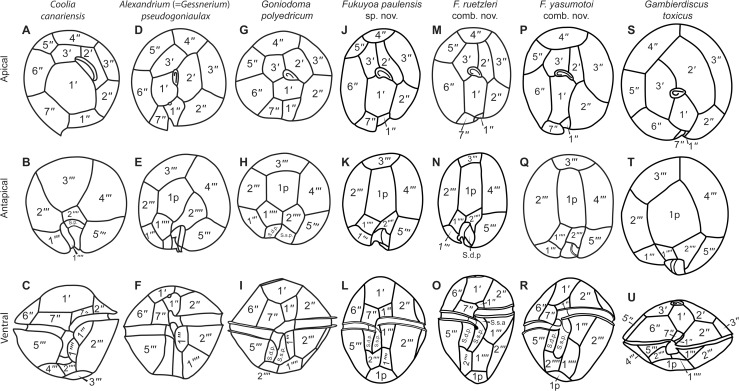
Line drawings of members of the family Goniodomataceae in apical, antapical and ventral views.(A-C) Coolia canariensis redrawn from Fraga et al. [27]. (D-F). Alexandrium pseudogoniaulax redrawn from Balech [25]. (G-I) Goniodoma polyedricum redrawn from Balech [25]. (J-L) Fukuyoa paulensis gen. et sp. nov. (M-O) F. ruetzleri comb. nov. redrawn from Litaker et al. [11]. (P-R) F. yasumotoi comb. nov. redrawn from Litaker et al. [11]. (S-U) G. toxicus redrawn from Litaker et al. [11].